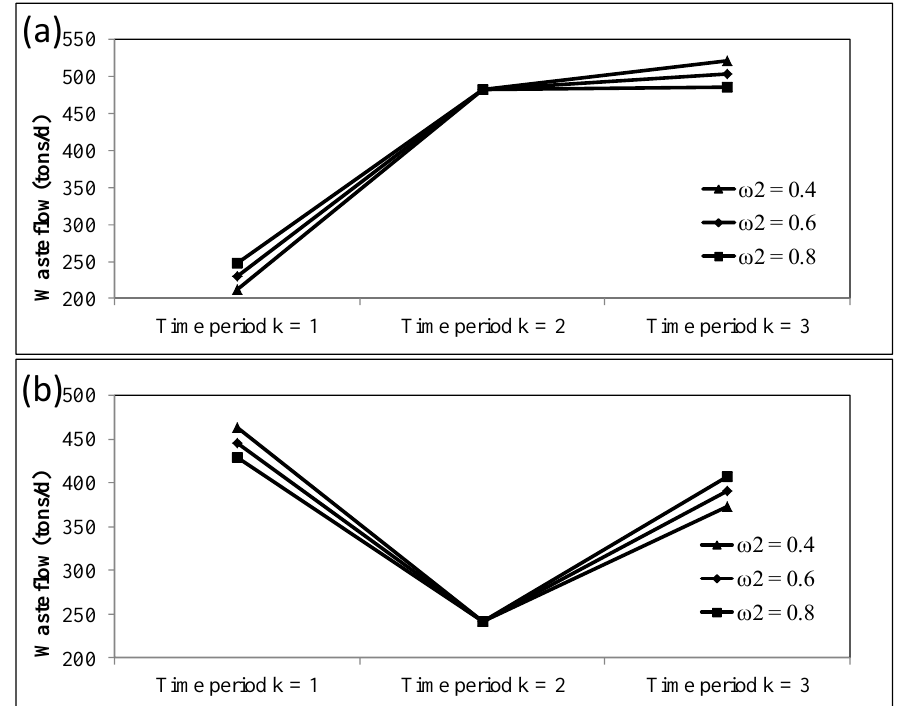
Figure 3. Total waste flow to facilities under di ff erent ω 2 degrees when β = ω 1 = 0.4: ( a ) to landfill; ( b ) to incinerator.